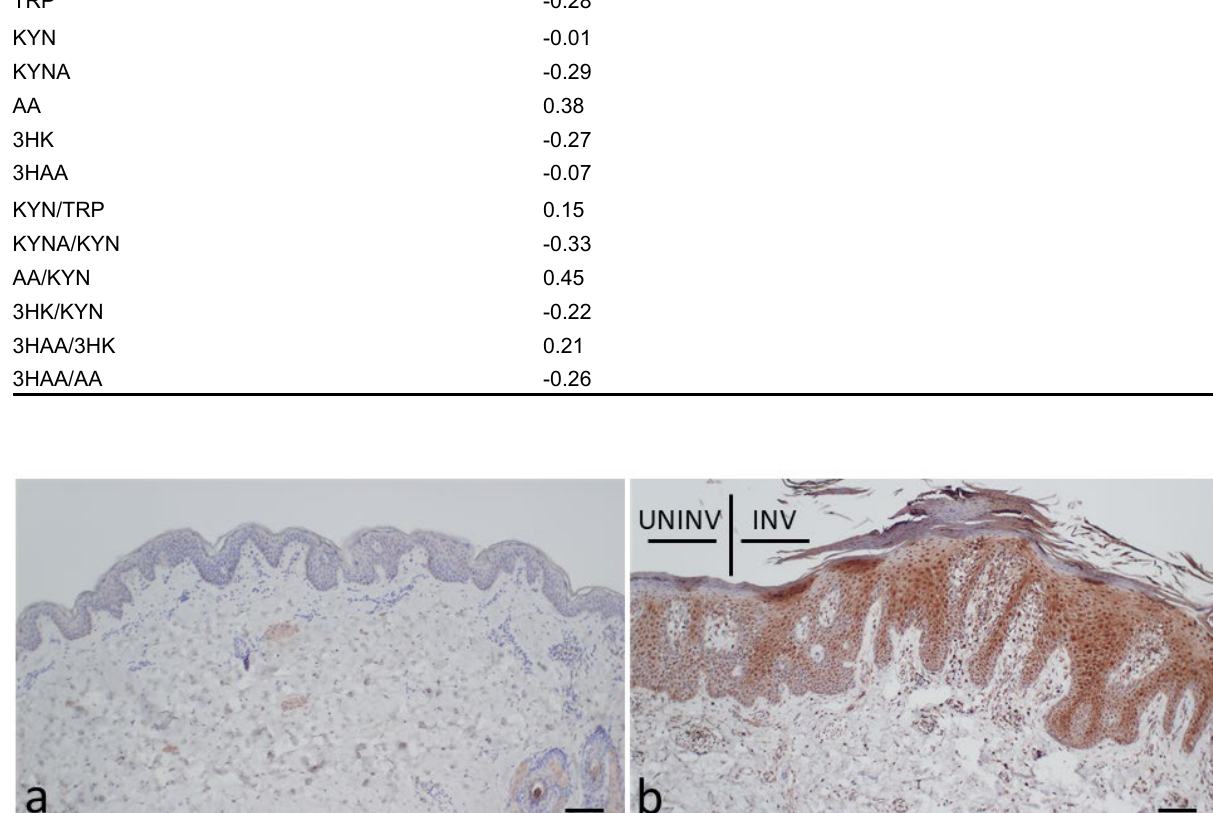
Table 3. Pearson’s correlation coefficients between PASI score and the TRP-KYN pathway metabolites in PSOs Metabolites and ratios